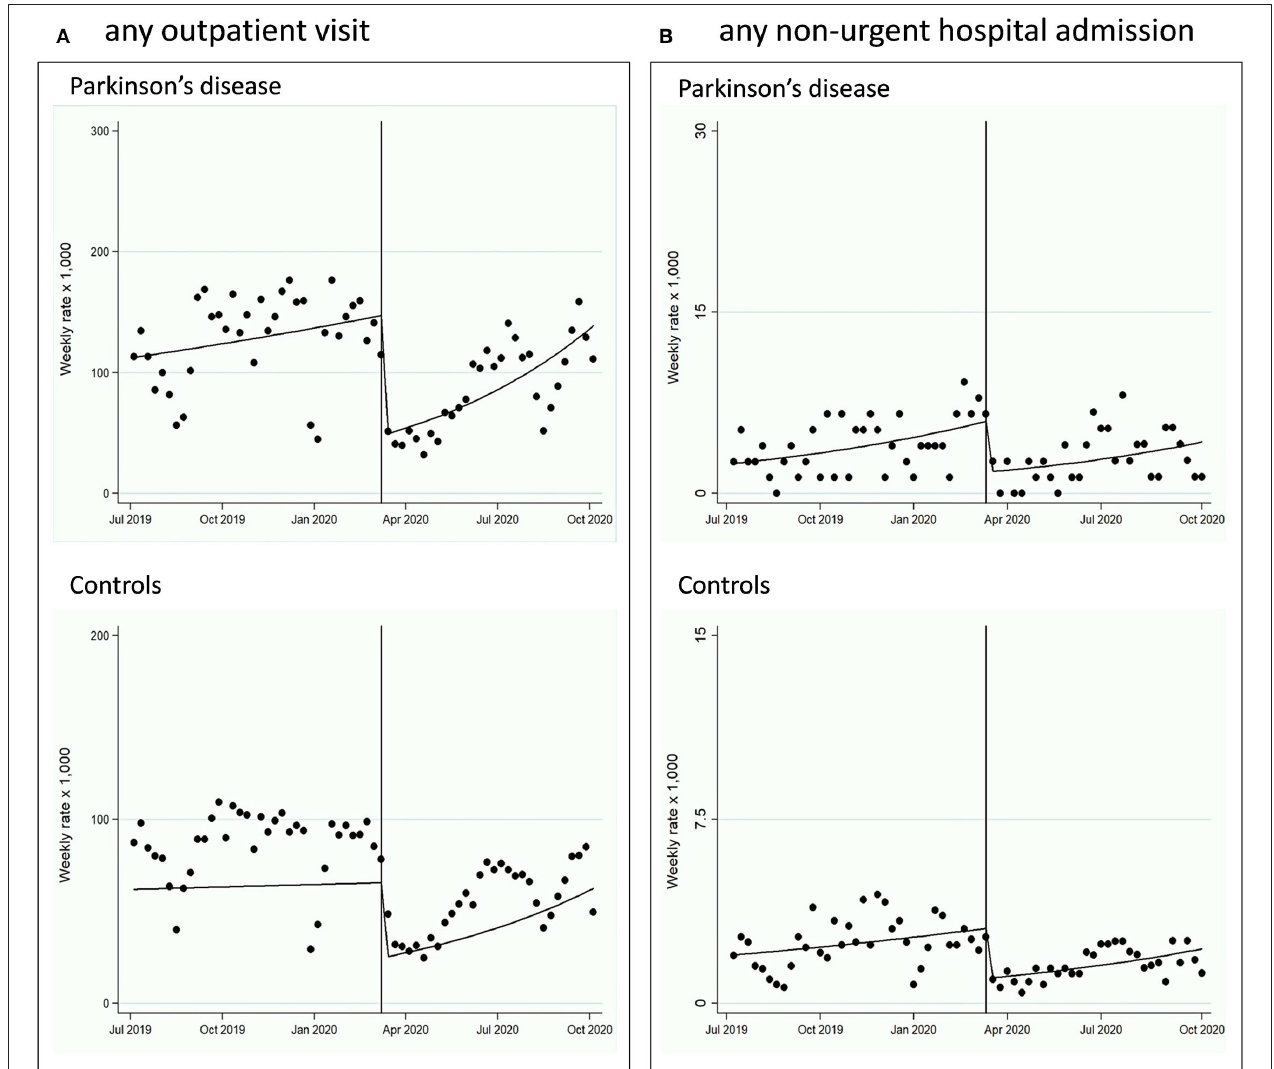
FIGURE 2 | Interrupted time-series (ITS) design, from July 1, 2019, to September 30, 2020, evaluating the healthcare services change in the PD and control cohorts. The pre-intervention period was from July 1, 2019, to March 8, 2020; the intervention (index week change) was set in the week of March 9 to 15, 2020; the post-intervention period was from March 16, 2020, to September 30, 2020. (A) Any outpatient visit change is reported. (B) Any non-urgent hospital admission change is reported.